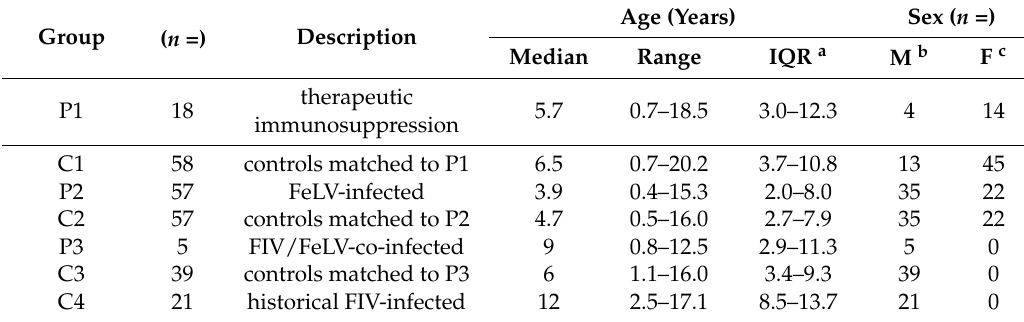
Table 1. Summary of patient group